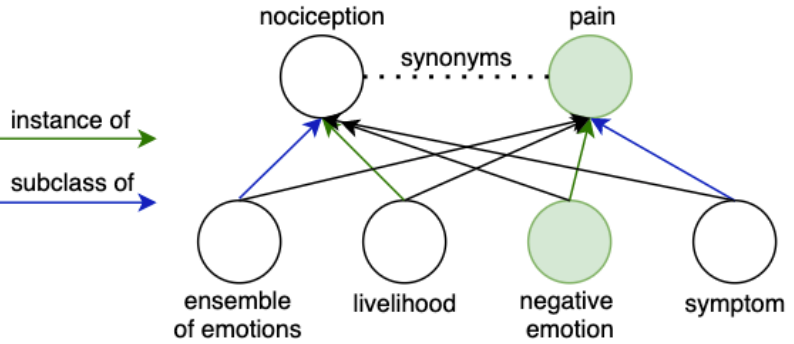
Figure 9. Example of ambiguous choice of labels in case of a presence of multiple synonymous en- tities.